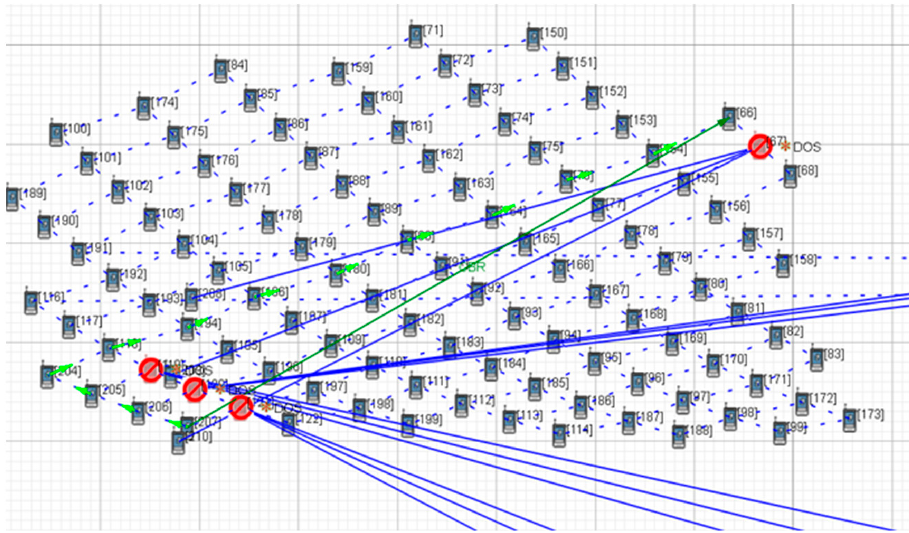
Figure 7. Four–satellite–key–node attack scenario. Figure 7. Four-satellite-key-node attack